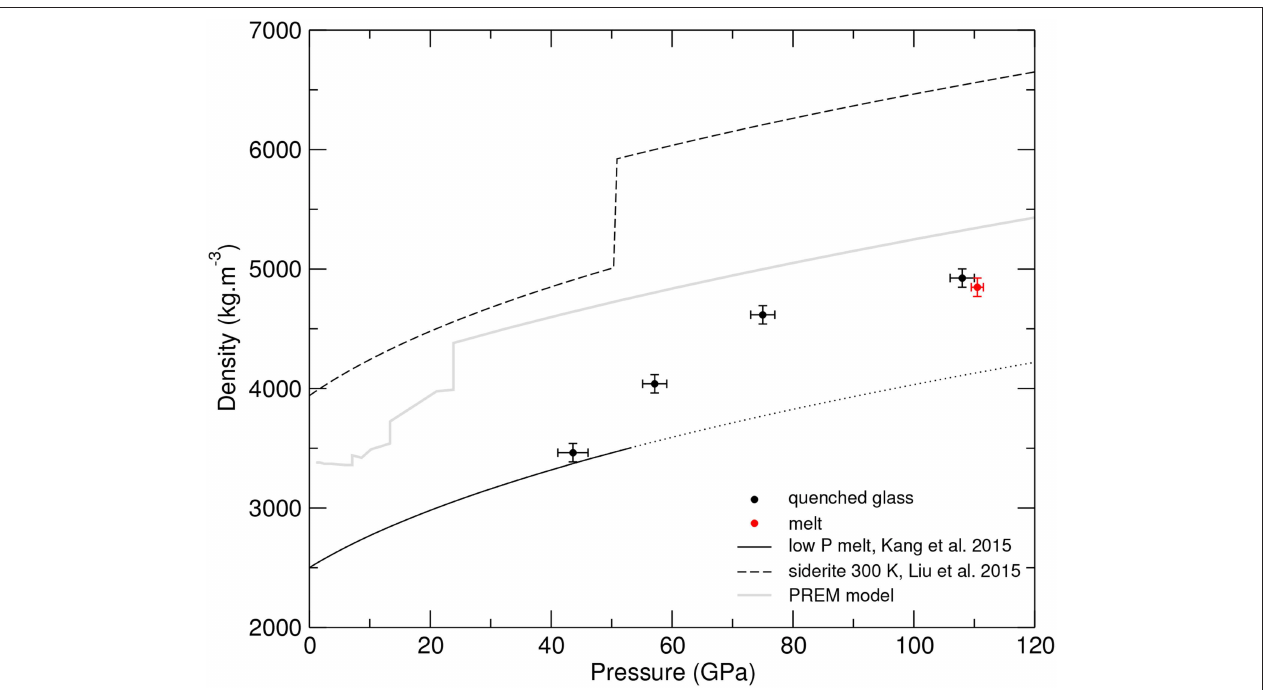
FIGURE 7 | Density evolution of glassy, molten, and cristalline siderite with pressure. Molten low P siderite (plain curve), high P data on glass (black points) and the highest P melt (red point), crystalline equation of state (dashed curve) includes the transition from high spin siderite I to low spin siderite II at 50 GPa (Liu et al.,